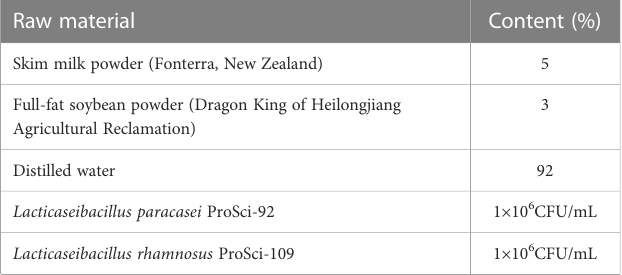
TABLE 1 The ratio of raw materials and the amount of probiotics inoculated. Raw material